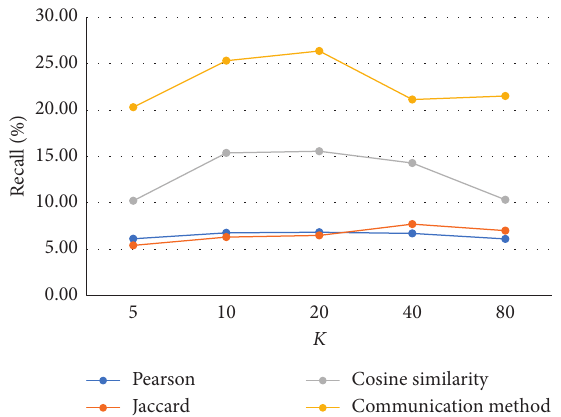
Figure 4: Recall of different user similarity calculation methods under multiple K